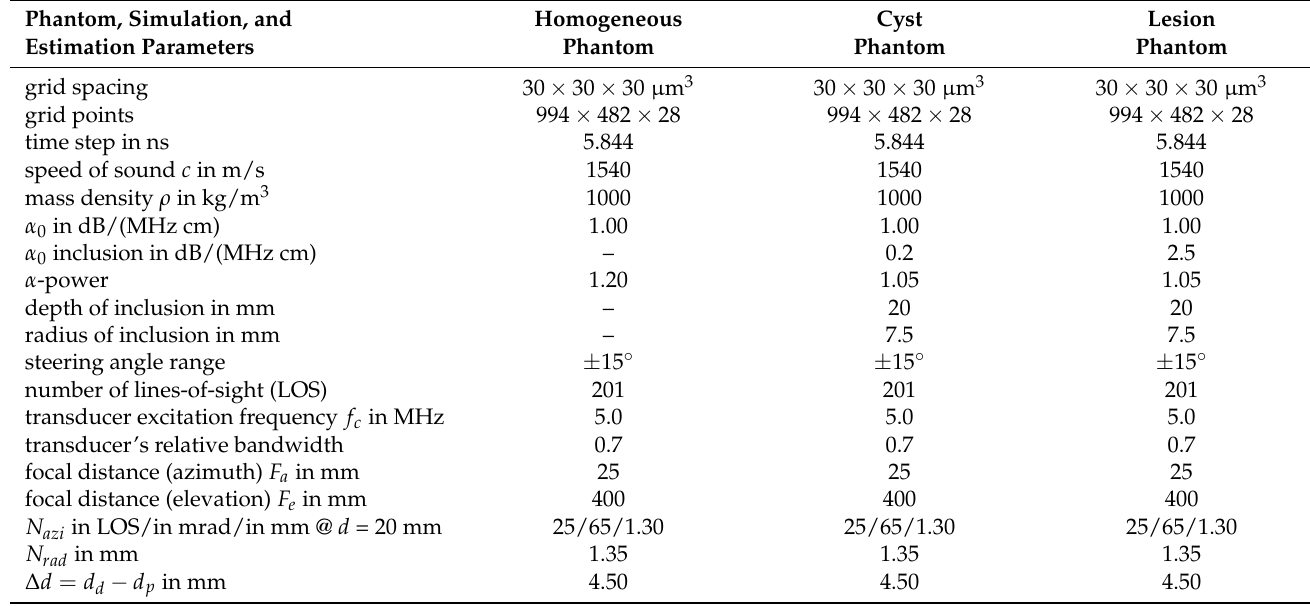
Table 3. Parameters of the k -Wave